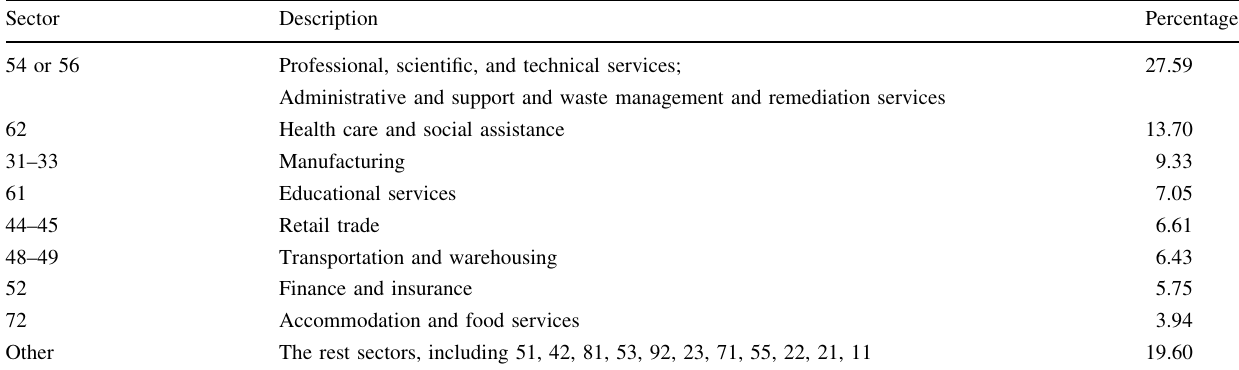
Table 1 Distribution of 9723 companies in each industry (according to 2017